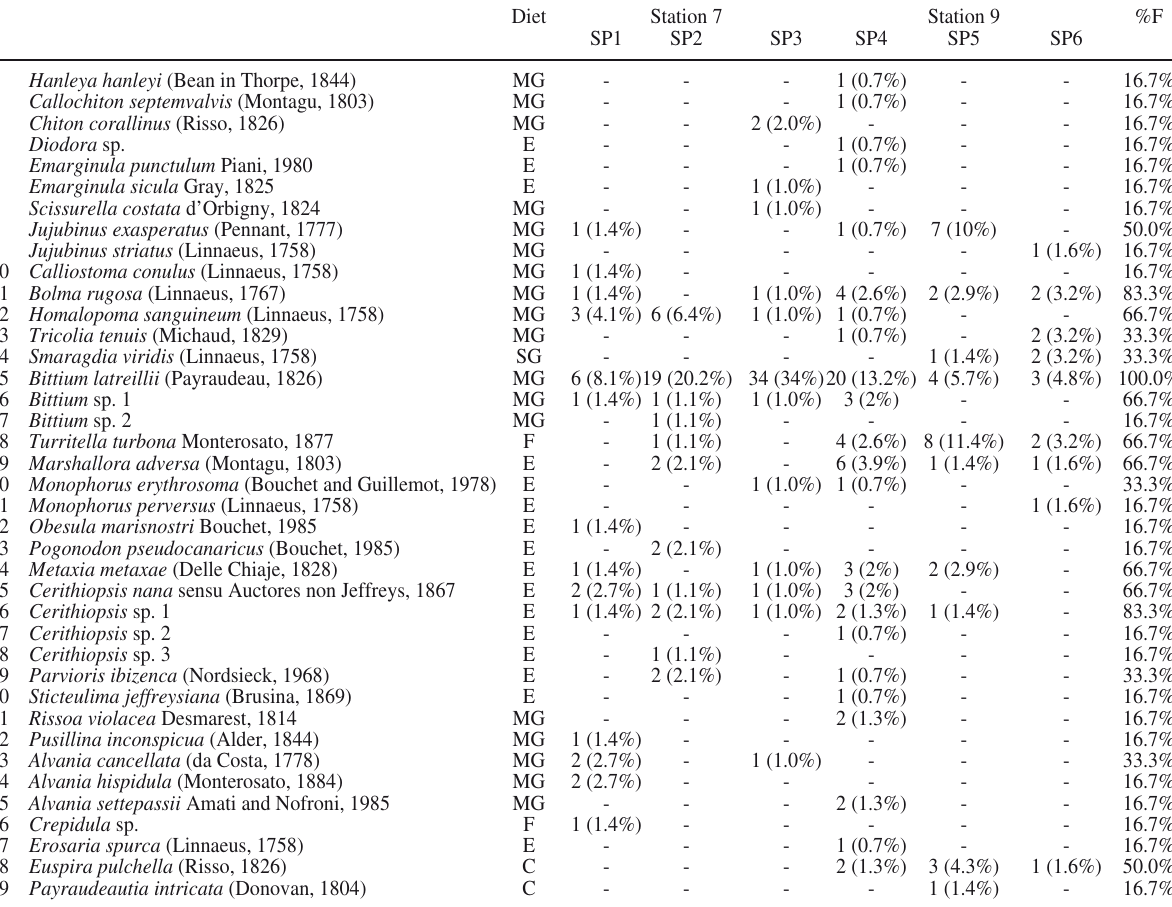
Table 4. – Faunistic list of molluscs found on the Posidonia rhizomes with quantitative data. The total number of individuals in each sample, the dominance index %D (between brackets), the frequency %F and the feeding guild code are given (C carnivores feeding on mobile organ- isms; SC scavengers; D deposit feeders; E ectoparasites and specialized carnivores; F filter feeders; AG macroalgae grazers; SG seagrass grazers; MG microalgal or periphyton grazers; O oophagus feeders; SY symbiont-bearing species). Biodiversity indices are reported at the bottom of the